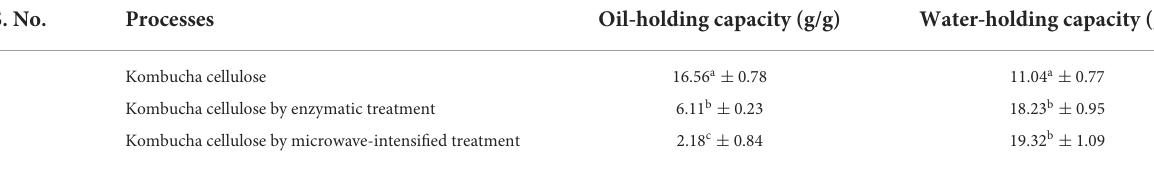
TABLE 1 Oil-holding and water-holding capacities of samples from various processing techniques. S.